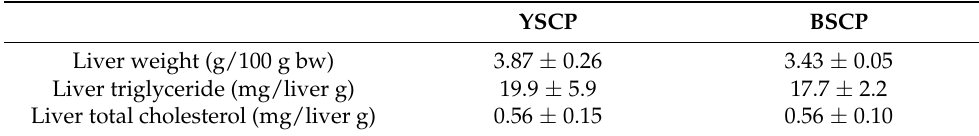
Table 5. Liver weights and lipid parameters of